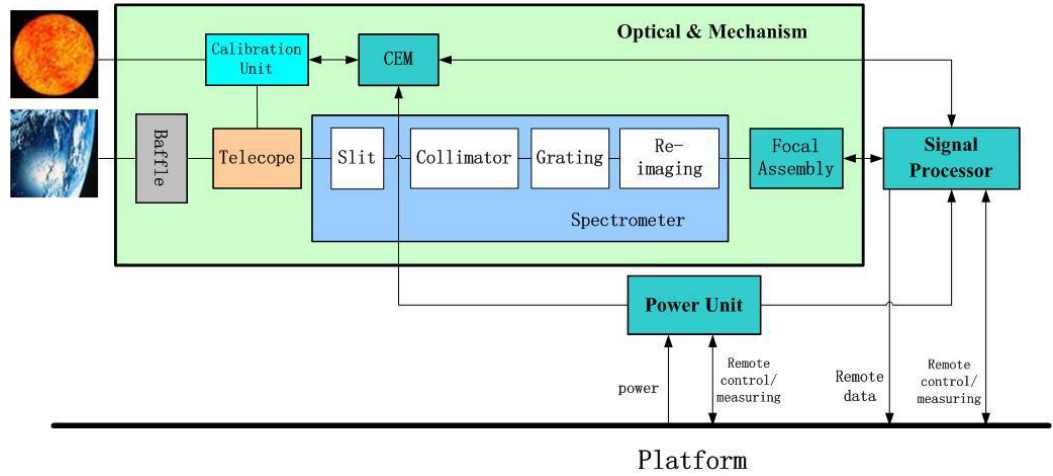
Figure 2. The concept of the SIF Imaging Spectrometer (SIFIS).